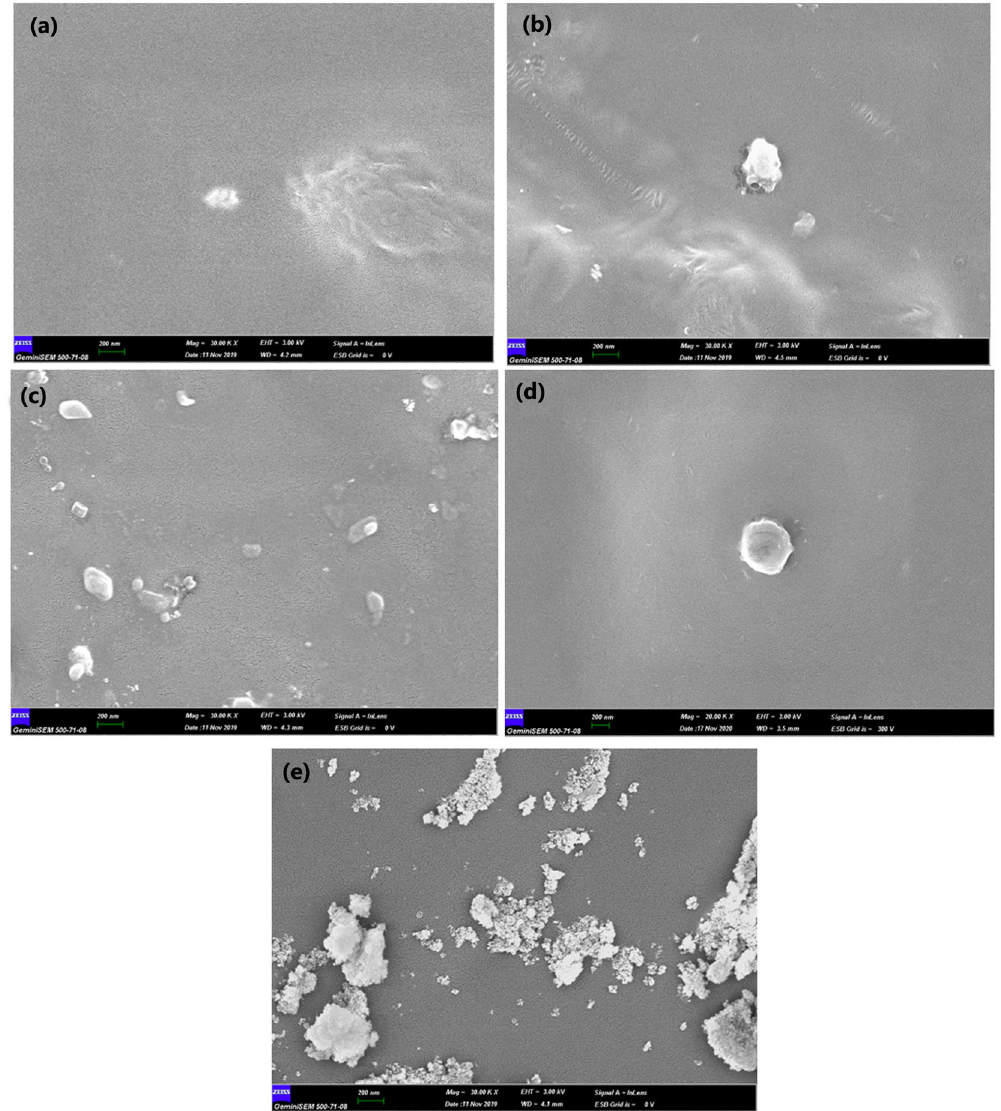
Fig. 2 Scanning electron microscope images of the samples. a Scanning electron microscope image of pure polypropylene without doping shows a fl at ground except for a small agglomeration due to the extruder machine ’ s principle pull. b large SiO 2 particles around 200 nm are detected when 0.5% fumed silica is added. c Particle size 200 nm and below. d An agglomerated coarse particle. e Particles more agglomerated in certain regions as the doping increases, which indicates why no more than 2% can be added to